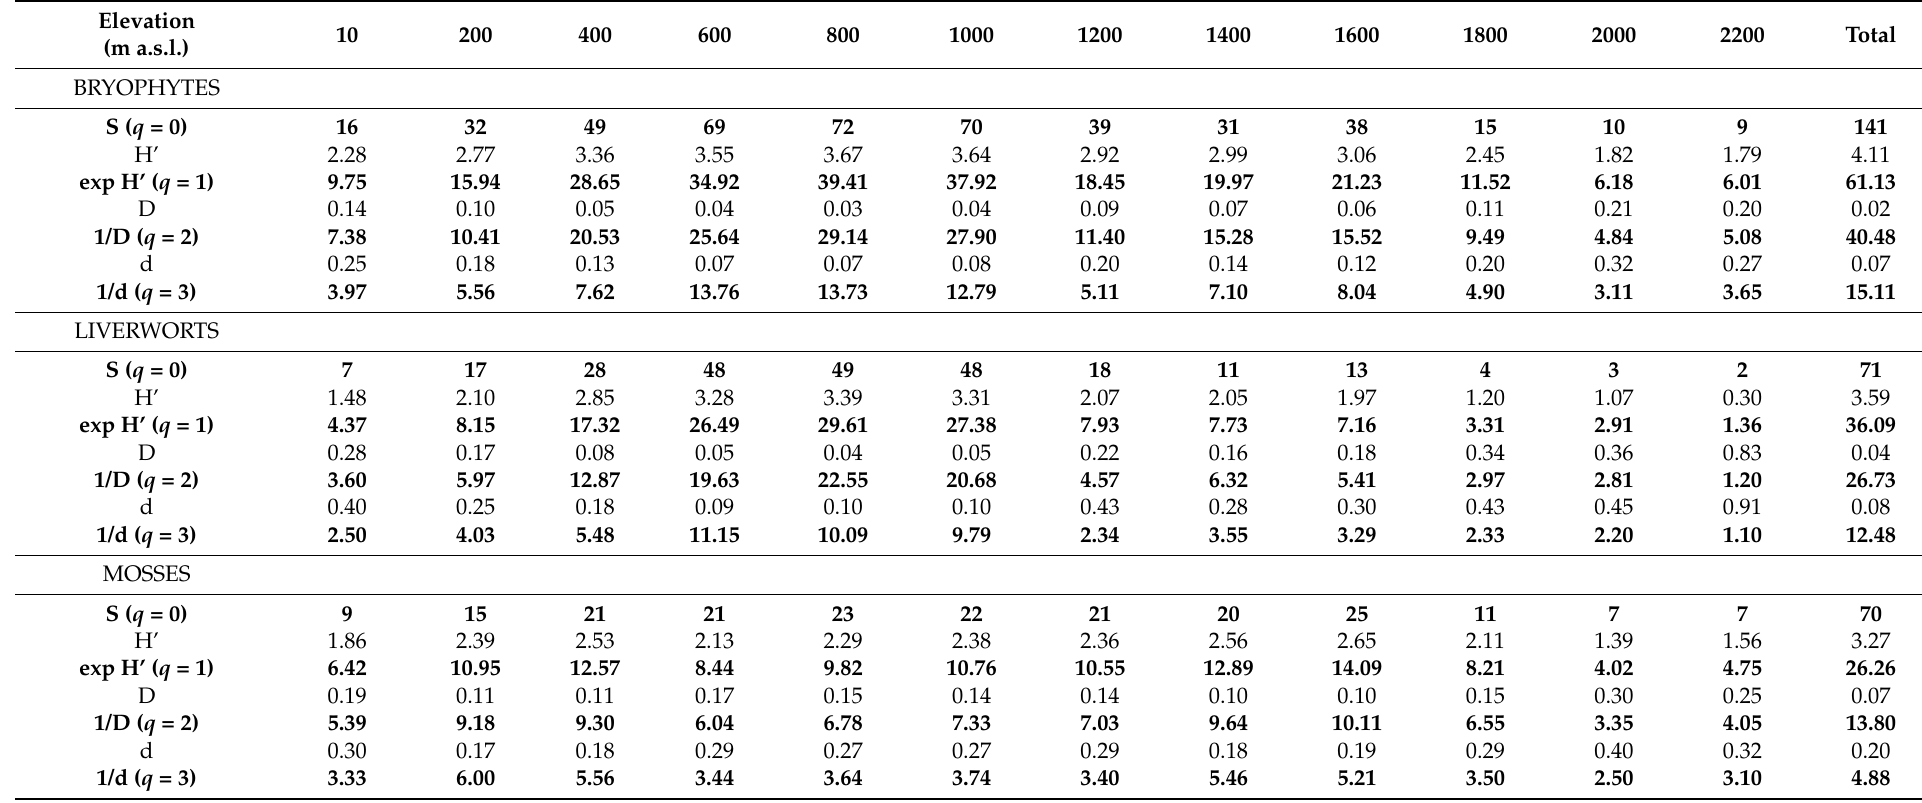
Table 2. Hill numbers for the 12 study sites along the elevational transect of Pico Island (S = richness of species; H’ = Shannon–Wiener index; D = Simpson index; and d = Berger–Parker